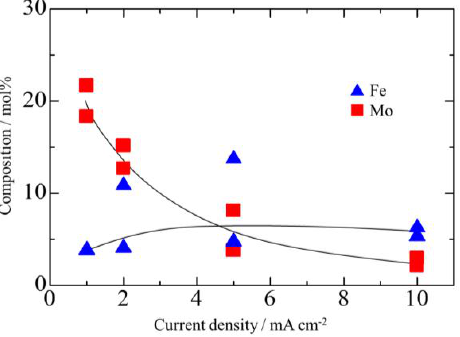
Figure 7. The content of Fe and Mo in the Zn–Fe–Mo plating deposited at various current densities.